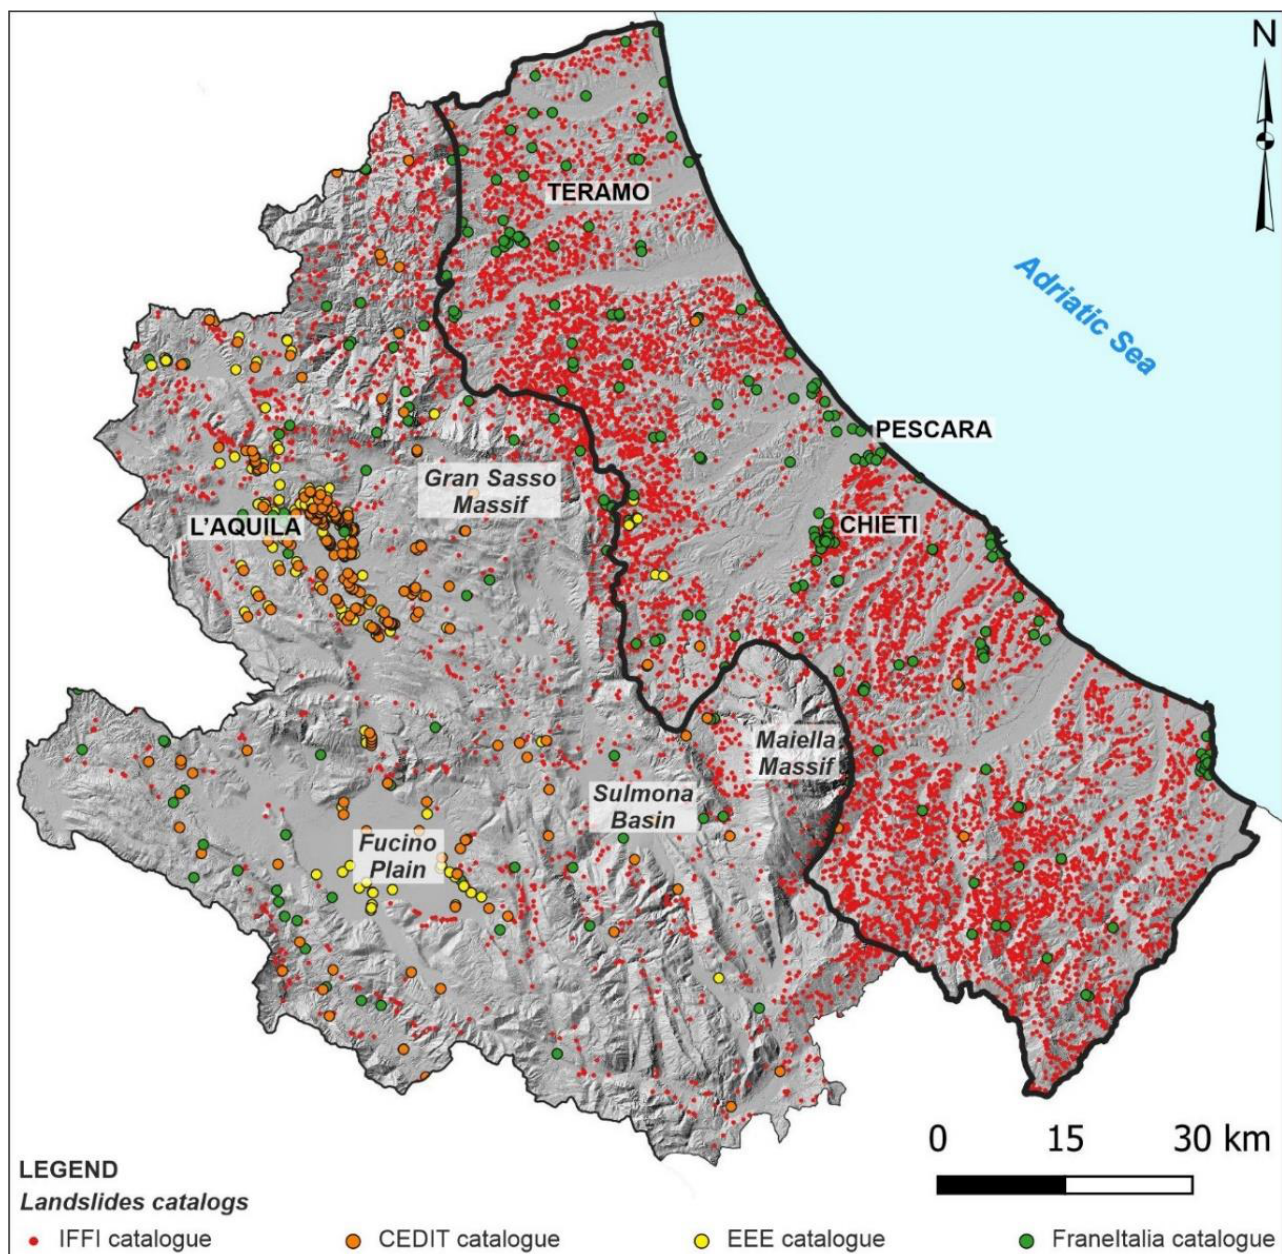
Figure 2. Landslide spatial distribution over the Abruzzo Region. This graphical representation includes the georeferenced location of rockfalls, landslides (lateral spreading, complex landslides, translational and rotational slides), debris flows, earth flows, DSGSDs, and soil creep areas. This general labelling derives from all historical documents, technical reports, and detailed information included in available inventories and databases, such as the Italian Landslide Inventory (IFFI) catalogue [60]; the Italian earthquake-induced ground failures (CEDIT) catalogue [61]; the Earthquake Environmental Effects (EEE) catalogue [64]; the FraneItalia catalogue [65]. The black line represents the study area.